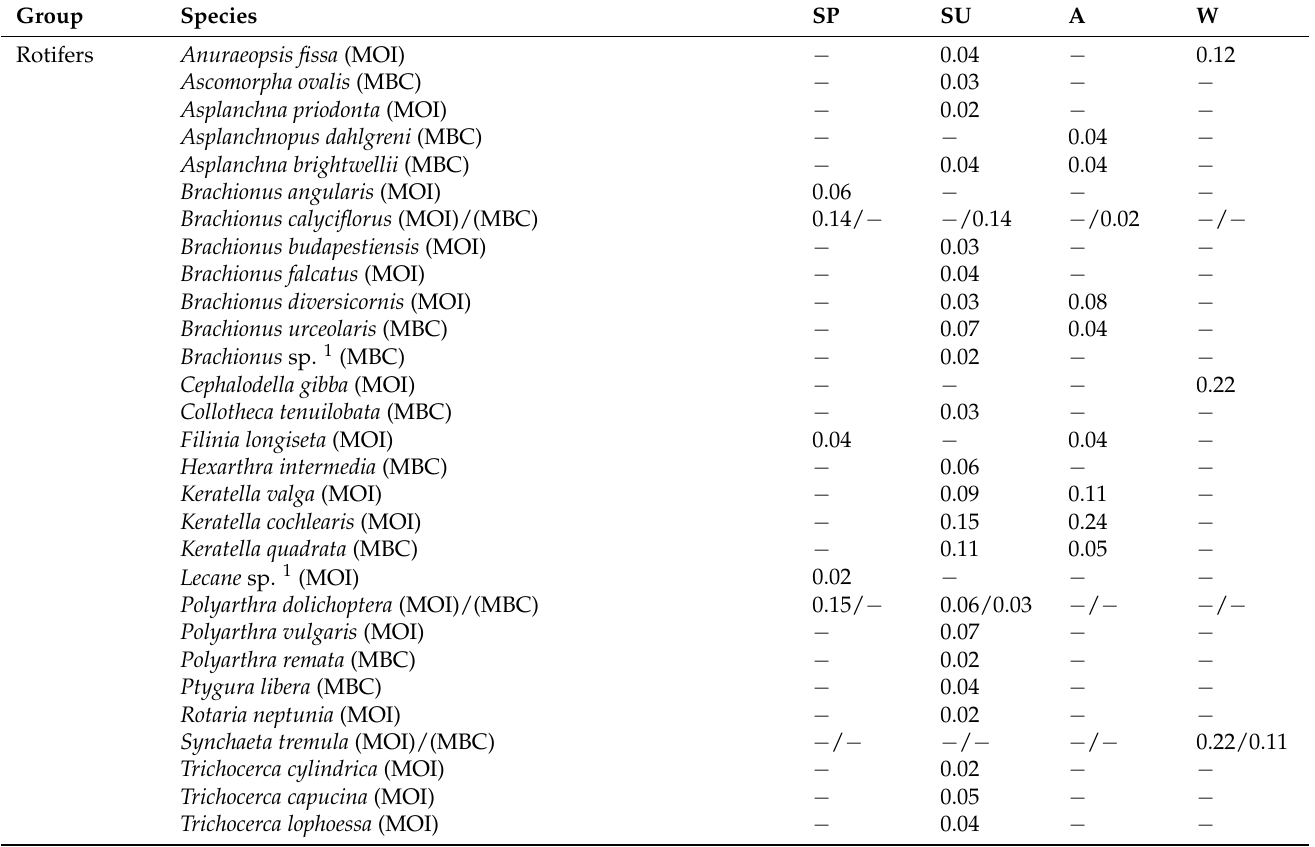
Table 1. Seasonal variation of dominant species found in Shahu Lake (China) in which morphological method (MOI) and DNA metabarcoding method (MBC) were